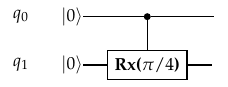
Figure 28. The local circuit for the first update frame of the one-dimensional PQCA example.